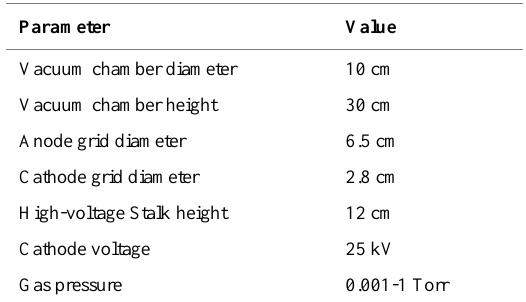
Table 1. Design and operational parameters of IEC fusion